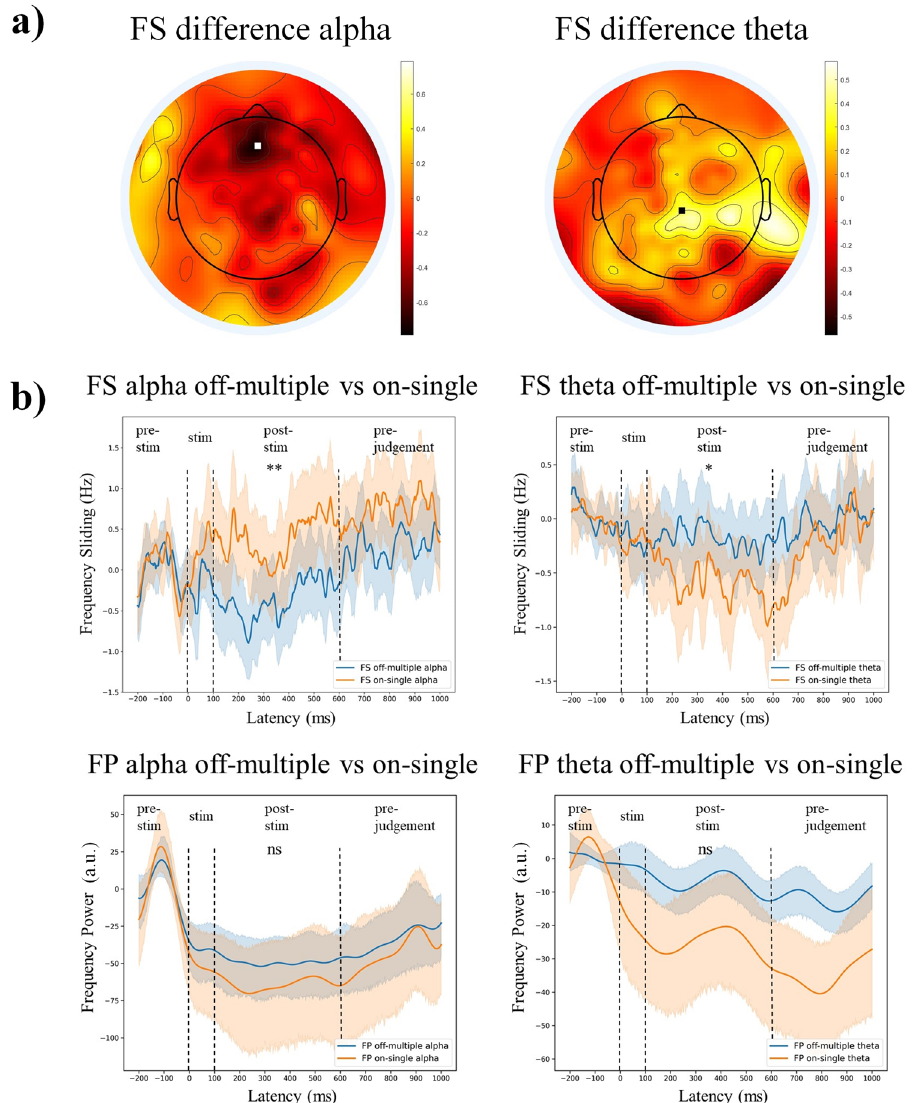
Fig. 4 Frequency sliding (FS) and frequency power (FP) during different thought types. a The difference map of FS post-stimulus ’ relative values. The difference map is calculated by subtracting on-single values from off-multiple values. According to visual inspection showing the strongest changes of FS, Fz was chosen for alpha FS and FP, CPz was chosen for theta FS and FP. b The time series of FS and FP relative values (subtracting the average of − 200 – 0 ms from all time points) under each condition (off-multiple and on-single) with the results of LMM of post-stimulus relative values between off- multiple and on-single. Signi fi cant differences were found between off-multiple and on-single thoughts in both alpha and theta FS but not in FP. * p < 0.05; ** p < 0.01; ns: no signi fi cance. Table 1 Results of the correlation between ERPs and FS.